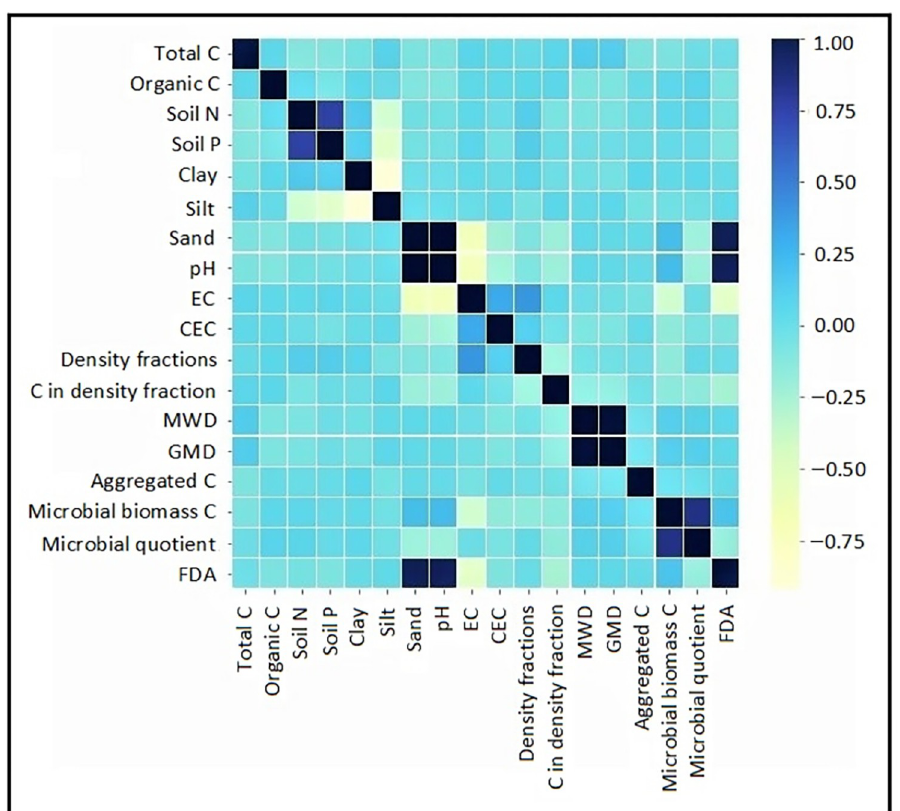
Fig 3. Heatmap of variables showing Pearson’s correlation coefficient.